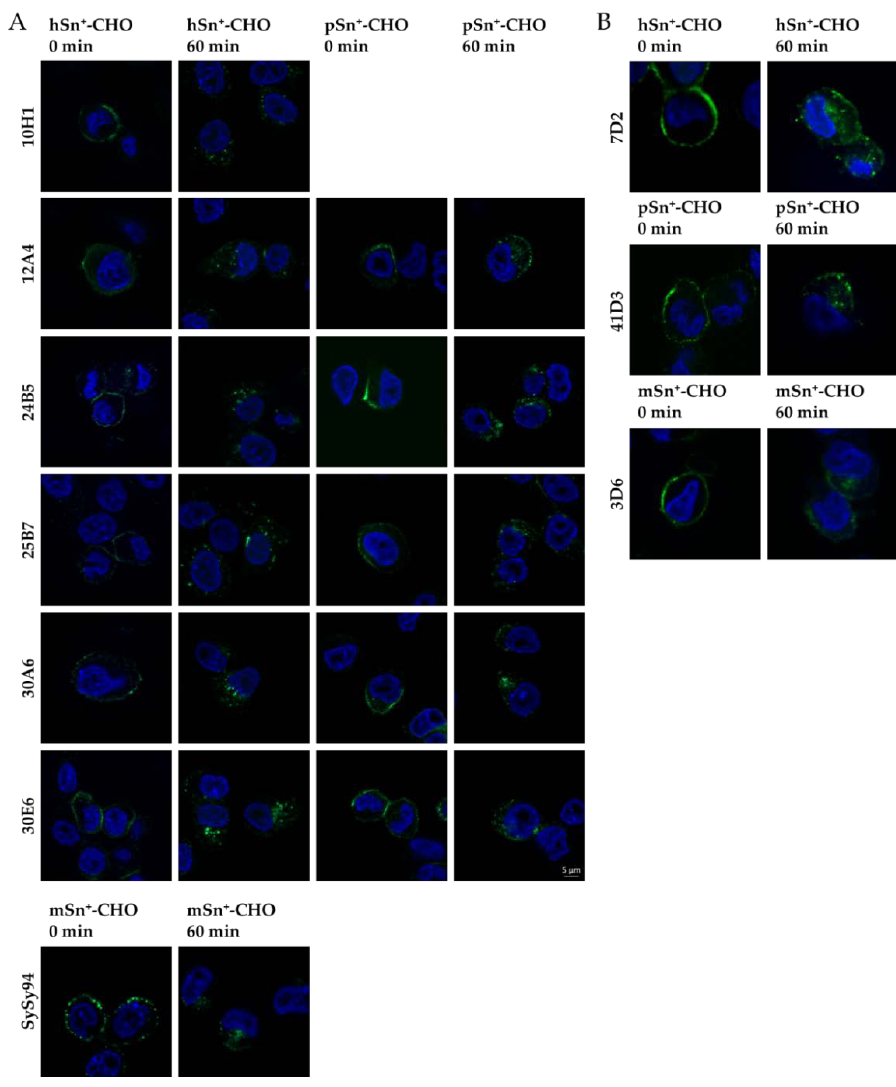
Figure 6. Internalization of Sn induced by different Sn-specific mAbs. ( A ) Newly developed mAbs and ( B ) reference mAbs were added to the cells for 60 min at 4 °C to allow only surface staining. Cells where then fixed (0 min) or were brought to 37 °C to induce internalization (60 min). Cells were permeabilized so internalized vesicles could be observed. Secondary Alexa Fluor 488-labeled antibodies were added to the cells (green) and DAPI was used to stain the nuclei (blue).